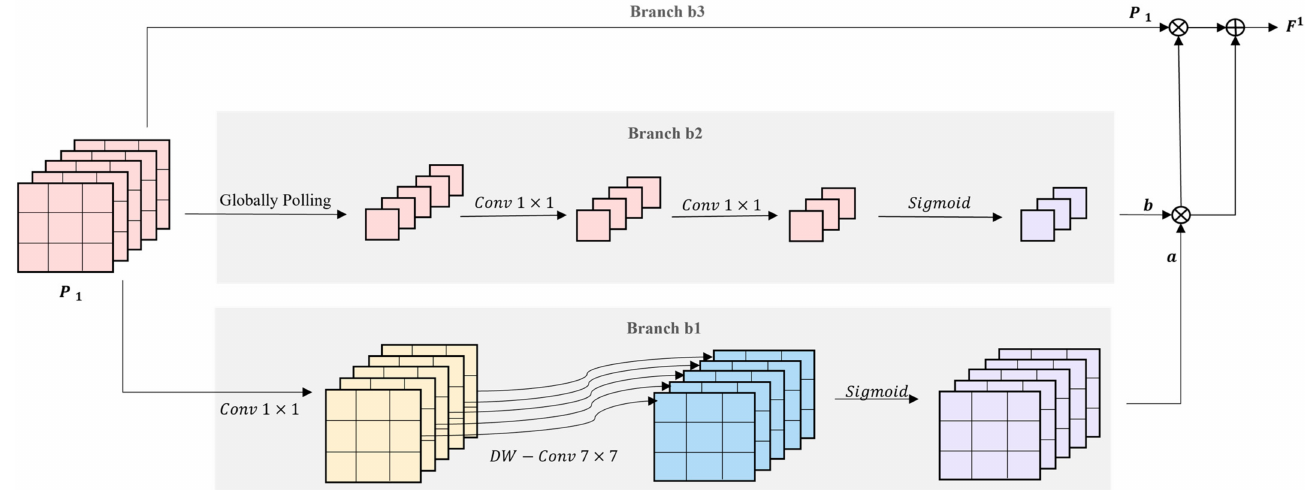
Figure 3. Feature refine model (FRM). The pooled features P 1 is fed into three branchs respectivately to aggregate a better region proposal feature